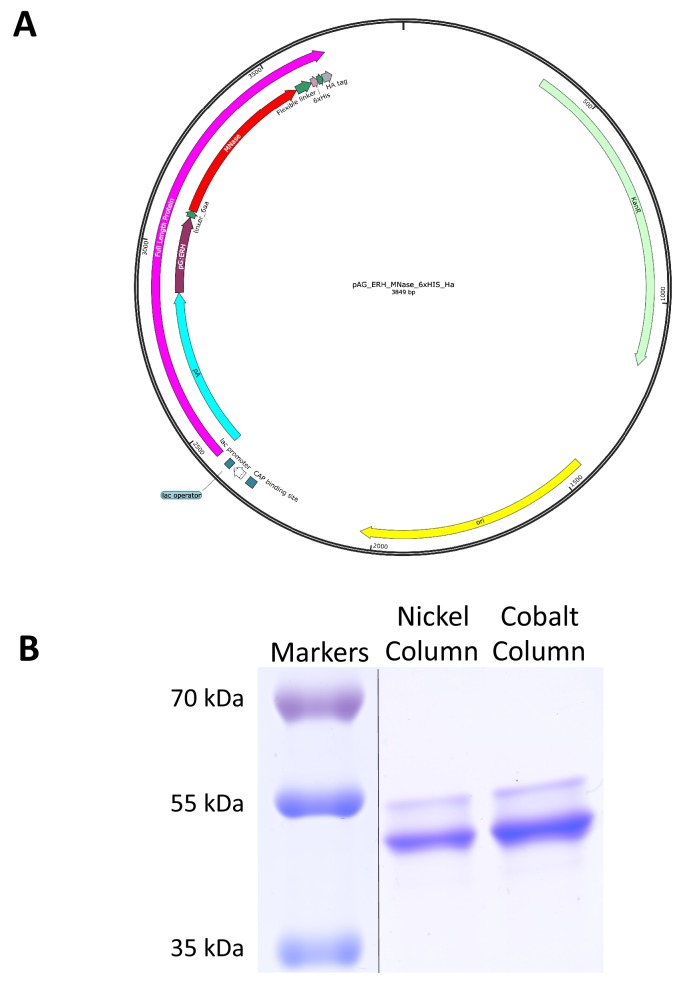
An improved fusion protein for CUT&RUN.(A) Plasmid map of pAG-ERH-MNase-6xHIS-HA. (B) Coomassie-stained gel of fusion protein eluted from nickel-agarose.